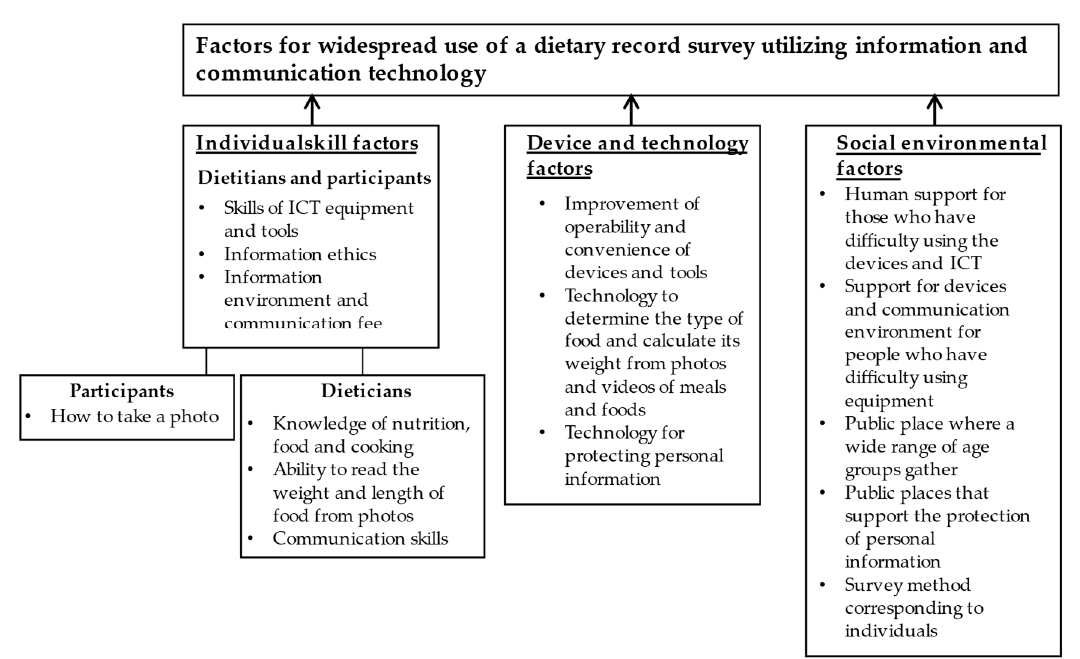
Figure 1. Categories and sub-categories of factors for widespread use of a dietary record survey utilizing information and communication technology (ICT) using focus group interview.